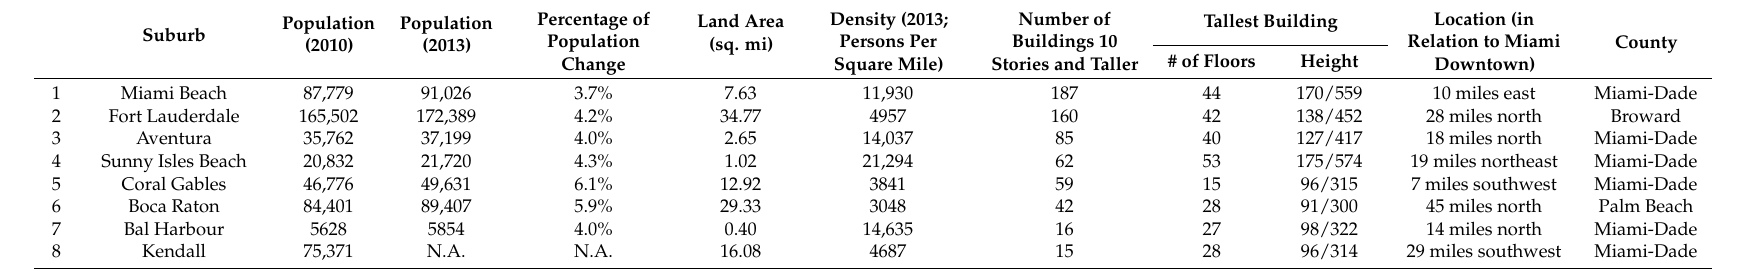
Table 4. Summary of the spatial profile of the examined suburban communities in the Miami region, FL